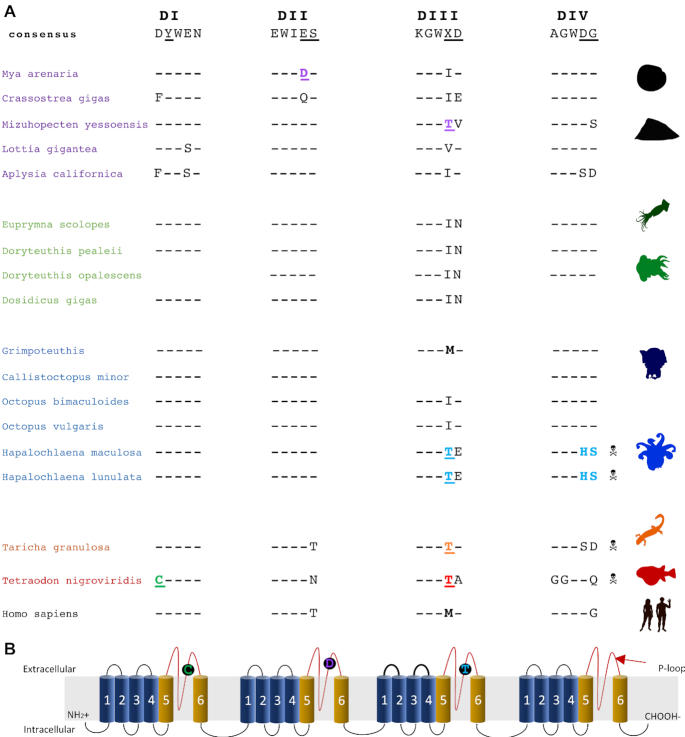
Mechanism of tetrodotoxin resistance within the posterior salivary gland of H. maculosa (PSG). (A) Alignment of voltage-gated sodium channel α-subunits (DI, DII, DIII, and DIV) p-loop regions. Mutations conferring resistance are coloured in green (pufferfish), orange (salamander), purple (clam), and blue (octopus). Susceptible mutations at the same site are black and boldface. Sites that may be involved with resistance are in boldface. (B) Schematic of voltage-gated sodium channel (Nav) α-subunits (DI, DII, DIII, and DIV). Each unit is composed of 6 subunits, 1–4 (blue) and 5–6 (yellow). Alternating extra- and intracellular loops are shown in black with the p-loops between subunits 5 and 6 highlighted in red. Mutations conferring resistance are shown within black circles on p-loops.